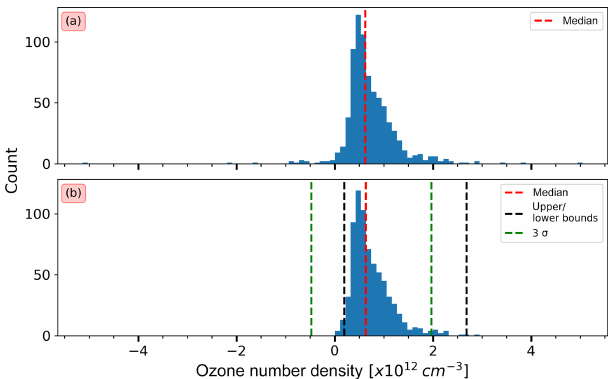
Figure 10. Probability density function of SAGE II ozone at 25km between 25 and 35 ◦ S for July. (a) Probability density function of SAGE II ozone before any screening is applied to the data. (b) Prob- ability density function of SAGE II ozone after the 200% uncer- tainty rule and the aerosol LOS optical depth rule were applied. The red line indicates the median of the distribution shown in each panel, while the dashed black lines represent the upper and lower boundaries calculated as described in the text. As a reference, panel (b) includes 3 times the standard deviation of the distribution (3 σ ) to represent the selection criteria similar to current rule no. 11. All data points that lie outside the dashed black lines will be removed from the data set. For more details, see the main text.